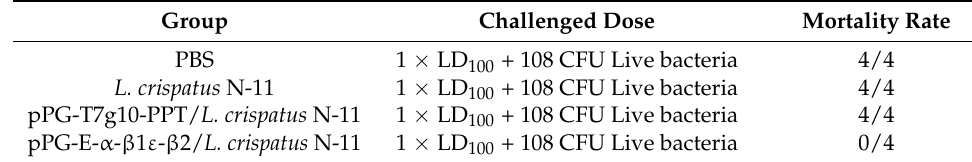
Table 2. Immunized chickens challenged with C. perfringens toxin.